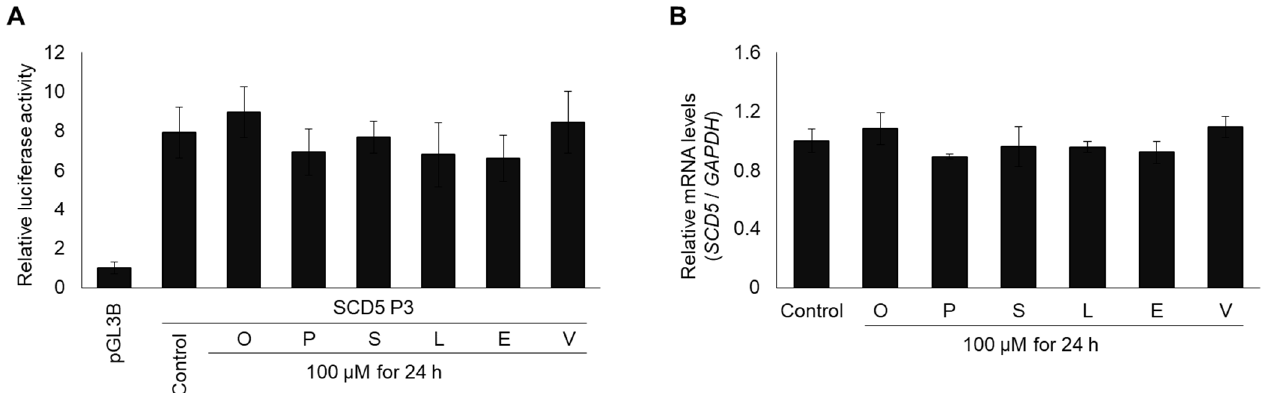
Figure 3. Effect of different fatty acids on relative SCD5 promoter activity ( A ) and on mRNA level ( B ). ( A ) Transfection and FA treatment were performed as described in Section 2. pCMV- β -gal vector served as transfection control. Luciferase and β -galactosidase enzyme activities were measured as indicated in Section 2 and their relative ratios are shown as bar graphs. The diagram depicts the results of three independent measurements that were normalized to pGL3B “empty” promoterless vector. ( B ) The mRNA expression was measured in FA treated HEK293T cells. Samples were treated and prepared as described in Section 2. qPCR was performed using GAPDH and SCD5 sequence specific primers as indicated in Section 2. The diagram presents the results of three independent measurements. Data are shown as mean values ± S.D. Statistical analysis was performed by using the Tukey–Kramer Multiple Comparisons Test.